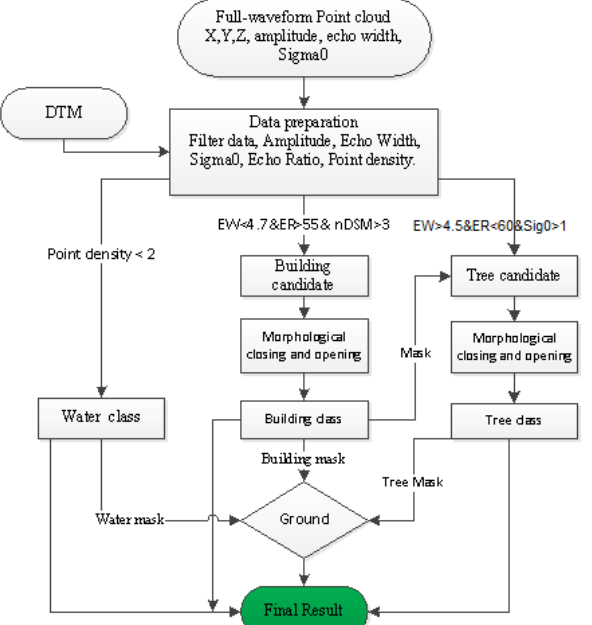
Figure 1. Decision tree for the